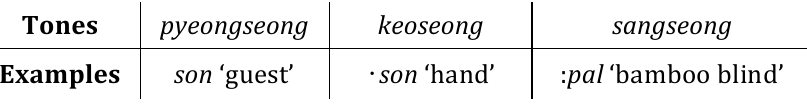
Table 6: Middle Korean tones in monosyllabic